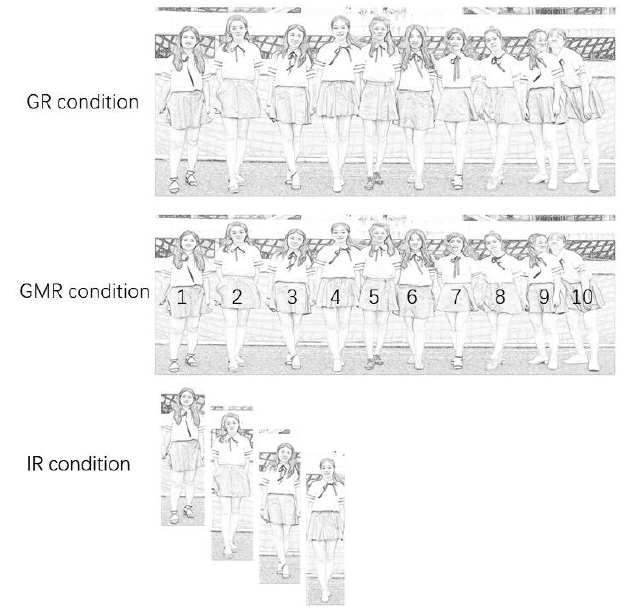
Figure 1. Sample photo stimuli for Study Ⅰ .